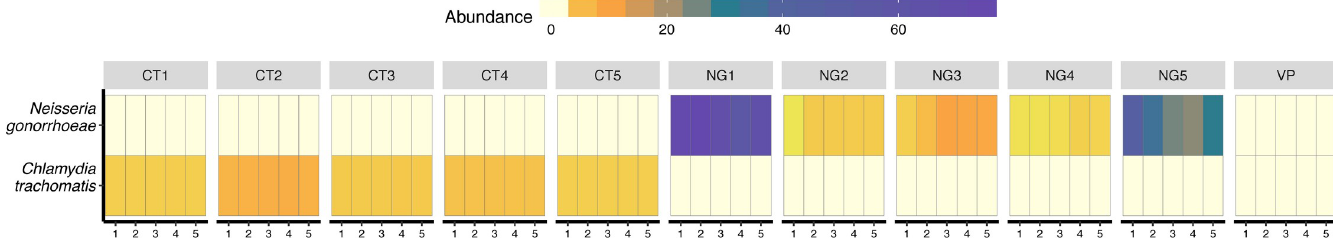
Fig 5. Experimental validation of 16S rRNA gene sequencing for pathogen detection using verification samples. Ten de-identified clinical verification specimens (iSpecimen) containing either C . trachomatis (n = 5) or N . gonorrhoeae (n = 5), as well as a vaginal pool (VP) constructed by combining 96 vaginal samples from 11 individuals, were tested for the presence of either pathogen using 16S rRNA gene amplification and sequencing. Five replicates of each specimen were tested. The heatmap shows the relative abundance of the two pathogens in each replicate experiment, on a scale from light yellow (absent) to dark purple (100% relative